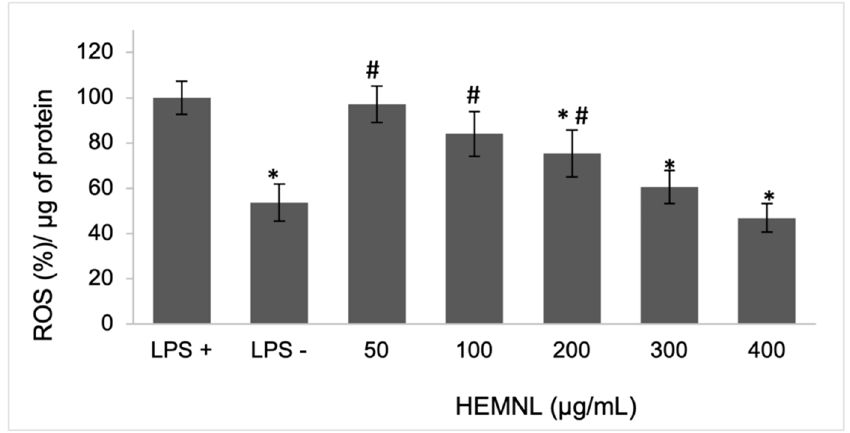
Figure 6. Inhibition of the production of reactive oxygen species in lipopolysaccharide (LPS)-stimulated cells. LPS+: positive control—cells stimulated with LPS and treated with vehicle (DMEM with 2% of ethanol). LPS − : negative control—cells not stimulated with LPS and treated with vehicle. Data represent mean ± standard deviation. * p < 0.001 in relation to LPS+; # p < 0.001 in relation to LPS − .